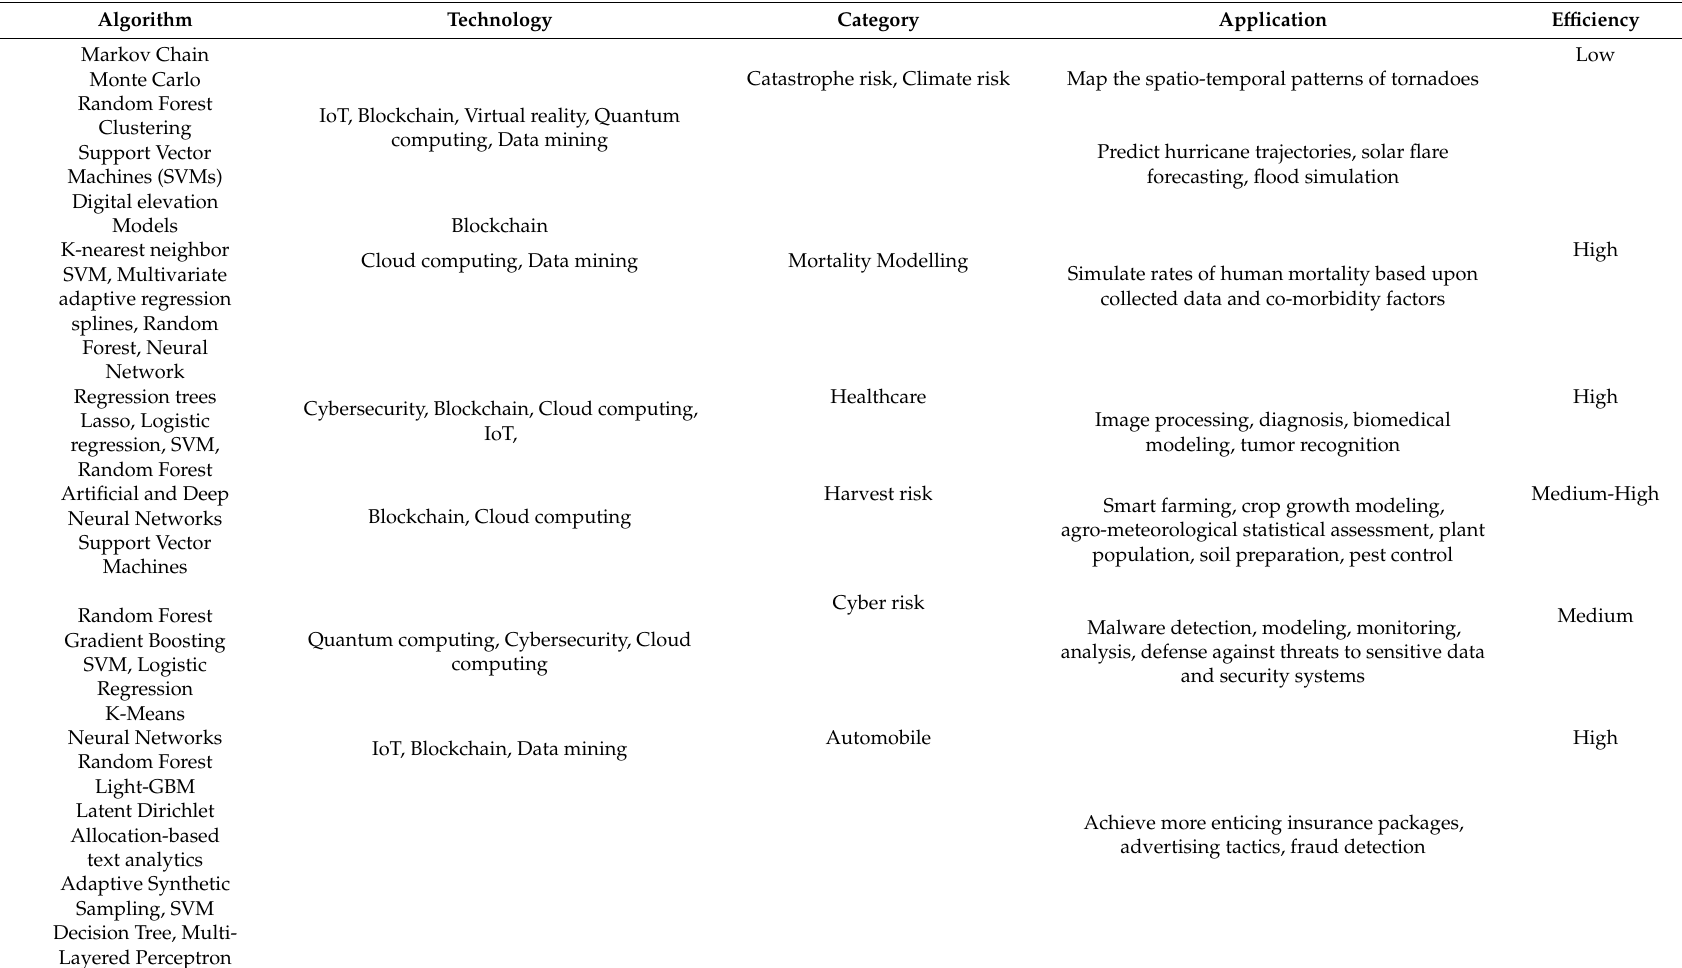
Table 1. Overview of machine learning algorithms applied in actuarial